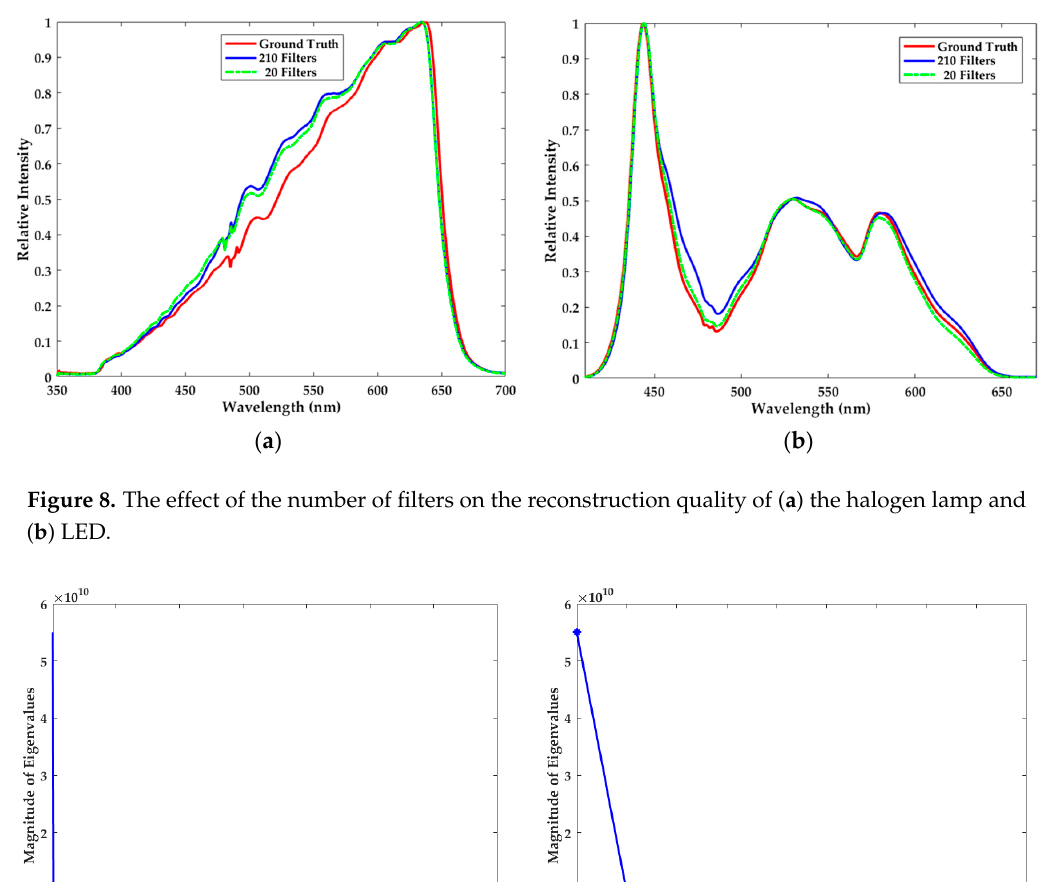
( a ) ( b ) Figure 7. The ground truth (red) and the reconstructed spectra of ( a ) the halogen lamp and ( b ) LED using the learned dictionary (blue) and Gaussian kernels (green). 4.4. Further Exploration As previously mentioned, the l 1 -norm minimization is adopted to solve the underdetermined system of linear equations, in which the number of filters is far smaller than the dimensionality of